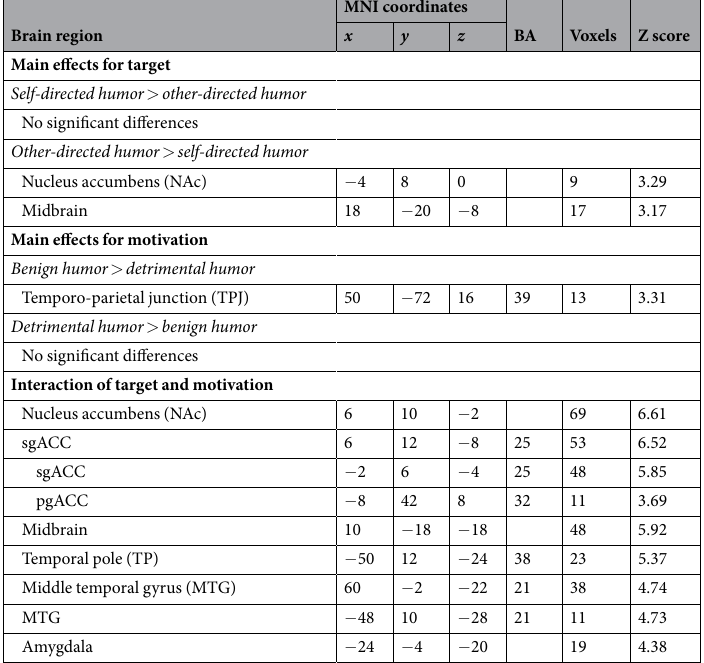
Table 1. Activated brain regions for the main effects and interaction between target (self/others) and motivation (benign/detrimental humor). Note: The activation threshold was set at p < 0.05 and FWE (familywise error rate) corrected at the peak level, and clusters greater than or equal to 8 are